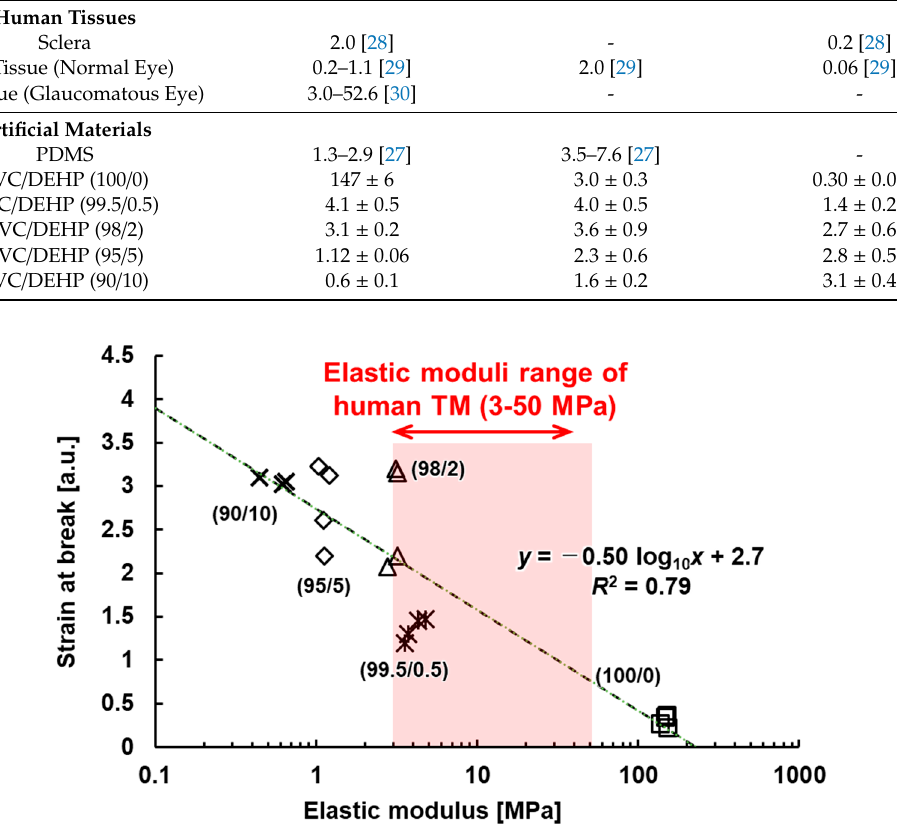
Figure 8. Elastic modulus and fracture strain of various concentrations of PVC/DEHP.